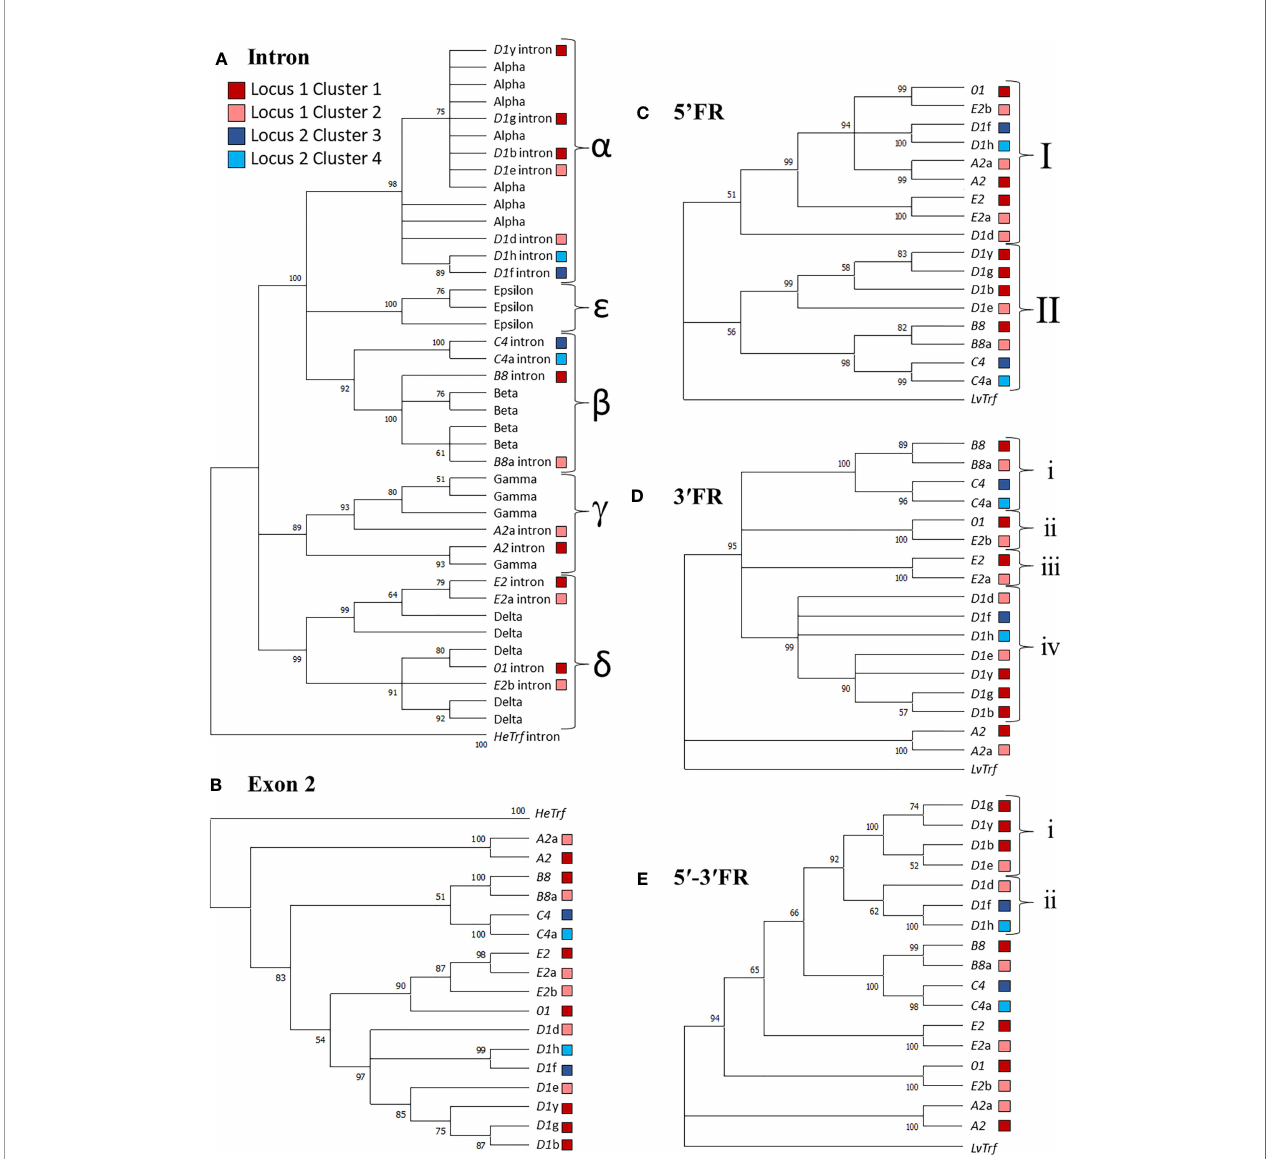
FIGURE 4 | Sequence similarities among the SpTrf genes and their putative evolutionary relationships are revealed by similar structures of maximum likelihood trees. Alignments were performed with PRANK, and Phylogenetic analysis was completed in MEGA7. Phylogenetic trees were generated using three approaches: neighbor joining, maximum parsimony (see Supplementary Figures S1 – S4 ), and maximum likelihood (shown), all of which resulted in similar tree structure. Colored boxes shown in the legend indicate the cluster in which the gene is located. Bootstrap values from 500 iterations are indicated for each tree. (A) The intron tree. The intron types (indicated by a - ϵ labels for separate clades) for each gene was identi fi ed using a previously published alignment of introns (19) with the introns from HeTrf genes de fi ned as the outgroup. (B) The exon 2 tree. Exon 2 from each gene was aligned and the exon 2 sequences from HeTrf genes were de fi ned as the outgroup. (C) The 5 ʹ FR tree. The 5 ʹ FR for each gene was selected using GenePallete and corresponded to 400 nt upstream of the start codon. The 5 ʹ FR of the LvTrf gene was used as the outgroup. (D) The 3 ʹ FR tree. The 3 ʹ FR for each gene was selected using GenePallete and corresponded to 400 nt downstream of the stop codon. The 3 ʹ FR of the LvTrf gene was used as the outgroup. (E) The concatenated 5 ʹ -3 ʹ FR tree. The 5 ʹ FRs and 3 ʹ FRs used in (C, D) were aligned and then concatenated prior to phylogenetic analysis. The concatenated 5 ʹ -3 ʹ FR of the LvTrf gene was used as the